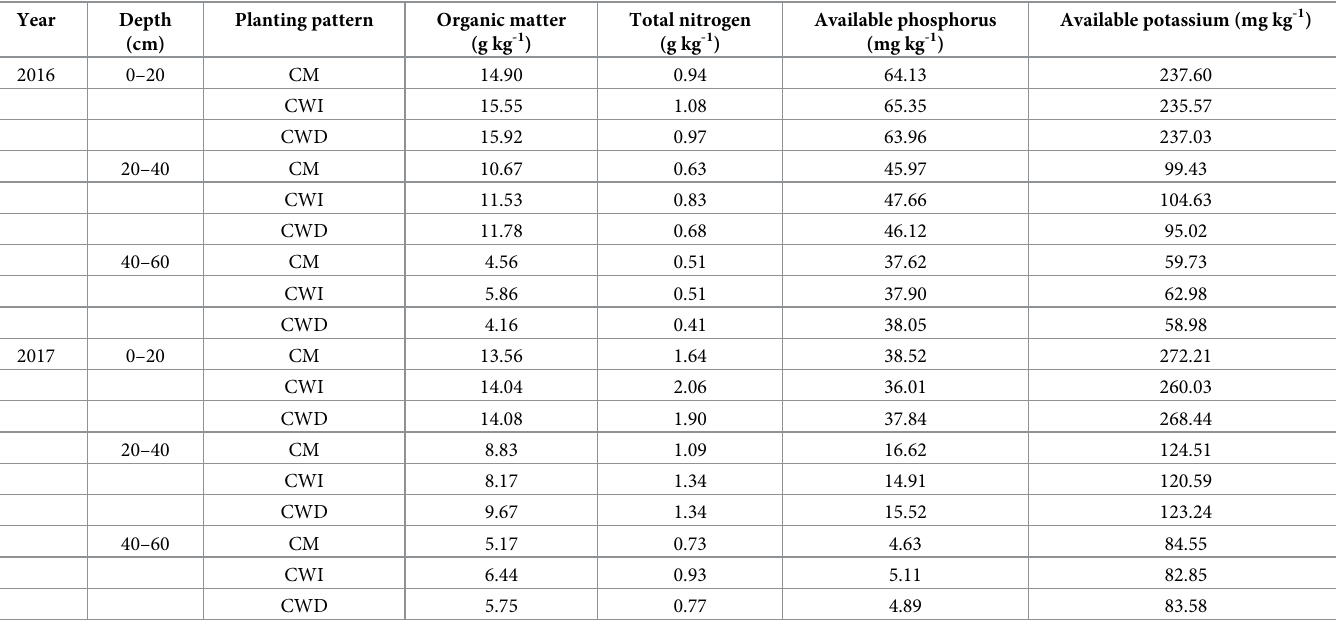
Table 1. Soil fertility of the experimental site in 2016 and 2017. Depth (cm)